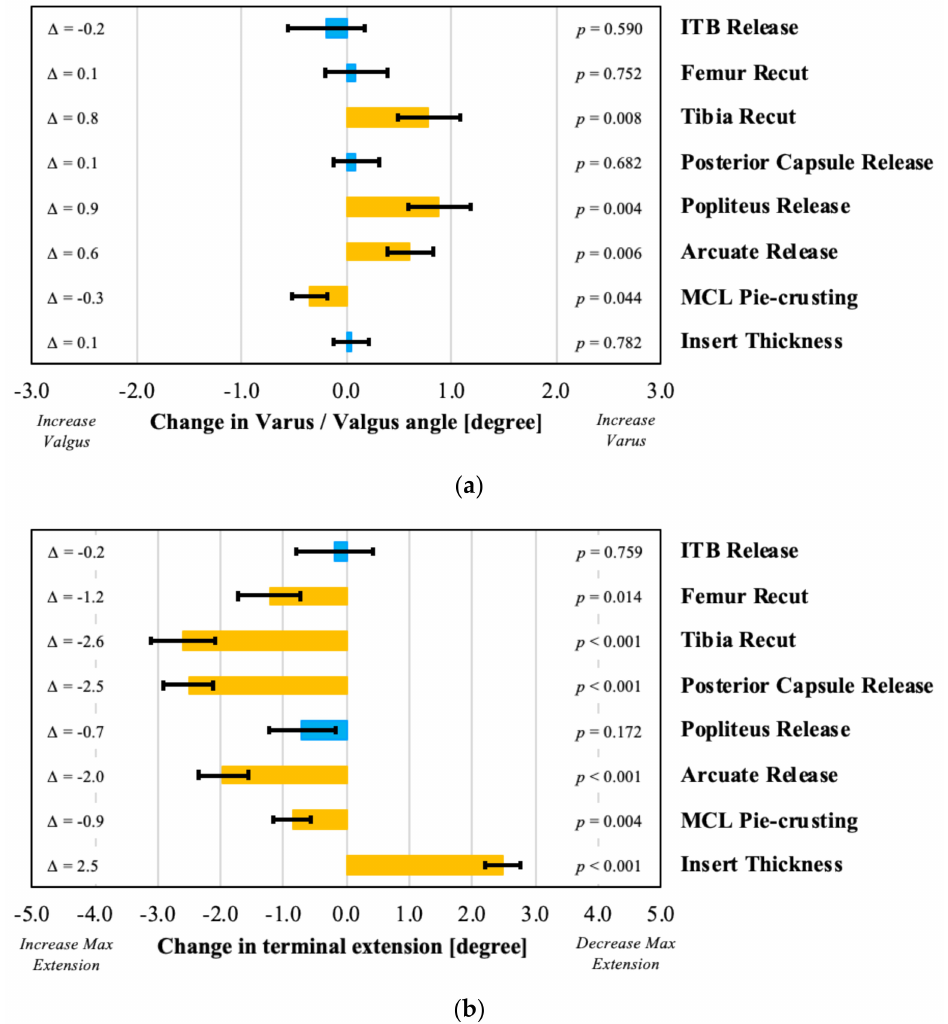
Figure 3. Evaluation of effect of various surgical decisions on ( a ) coronal (negative represents varus and positive represents valgus) and ( b ) sagittal alignment in extension (positive represents a decrease in terminal extension), with orange bars indicating statistically significant